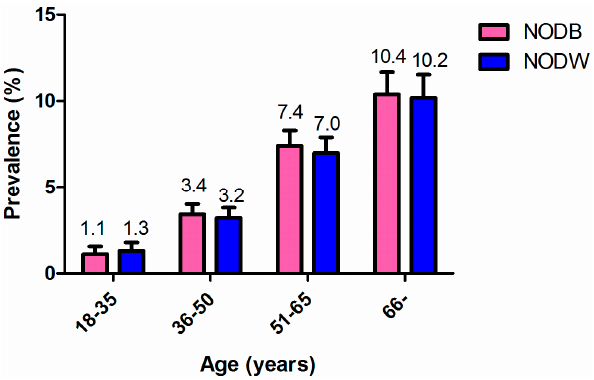
Figure 2. The prevalence of non-obese diabetes based on BMI (NODB) and WC (NODW) according to age groups. Both the prevalence of NODB and NODW increased with age.